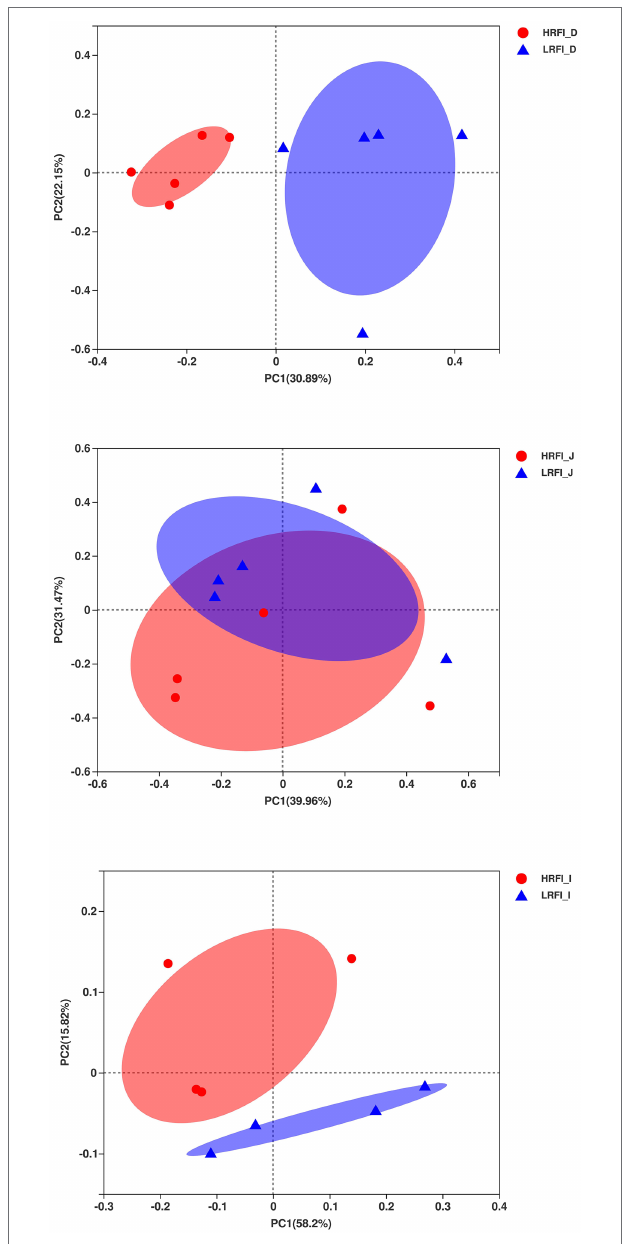
FIGURE 1 | Principal coordinate analysis (PCoA) of the duodenum, jejunum, and ileum bacterial